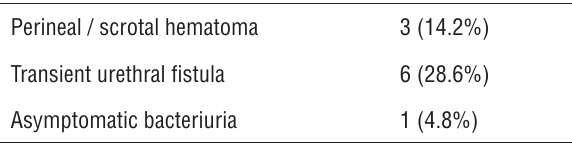
Table 2 - Previous procedures underwent by patients prior to combination urethroplasty.